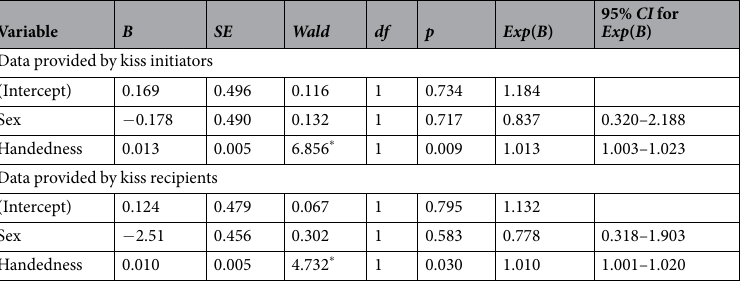
Table 2. Effects of sex and handedness on the overall head-turning direction demonstrated through binary logistic regressions. Note. N = 96. Coding independent variable, Sex: Male = 1.000; Female = 0.000 (Reference category). Coding dependent variable, Head-turning direction: Left = 0; Right =